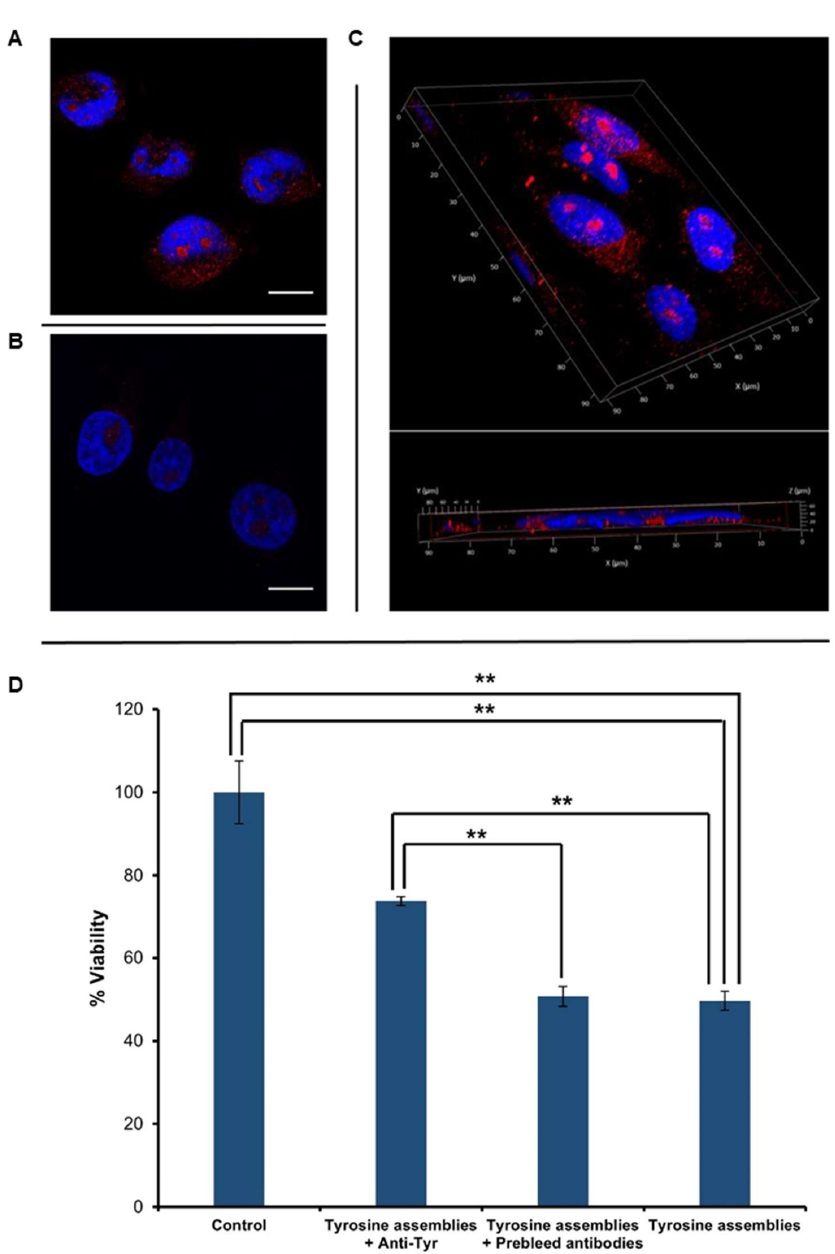
Figure 3. Cellular internalization and toxicity of Tyr assemblies. ( A – C ) Tyr was dissolved at 90 °C in cell culture medium, followed by gradual cooling of the solution. The control reflects medium with no Tyr assemblies, which was treated in the same manner. The cells were stained with anti-Tyr antibodies and visualized using confocal microscopy. DAPI (blue) and anti-Tyr staining (red) are shown. Scale bars: 15 µm. ( A ) SH-SY5Y cells treated with medium containing Tyr assemblies. ( B ) Control untreated SH-SY5Y cells. ( C ) 3D volume reconstruction of the Z-series with XZ-slice projection of treated cells. The interval between individual Z-stack serial images was 0.5 µm. ( D ) SH-SY5Y cells were treated with medium containing Tyr fibrils, which were pre-incubated with anti-Tyr antibodies (Tyrosine assemblies + anti-Tyr), Tyr fibrils pre-incubated with pre-immune antibodies (Tyrosine assemblies + pre-immune antibodies), and with medium containing non-treated Tyr fibrils (Tyrosine assemblies), following the addition of the MTT reagent. Absorbance was determined at 570 nm and 680 nm. The results represent three biological repeats. Values are means ± SD, student’s t -test, ** p < 0.001.